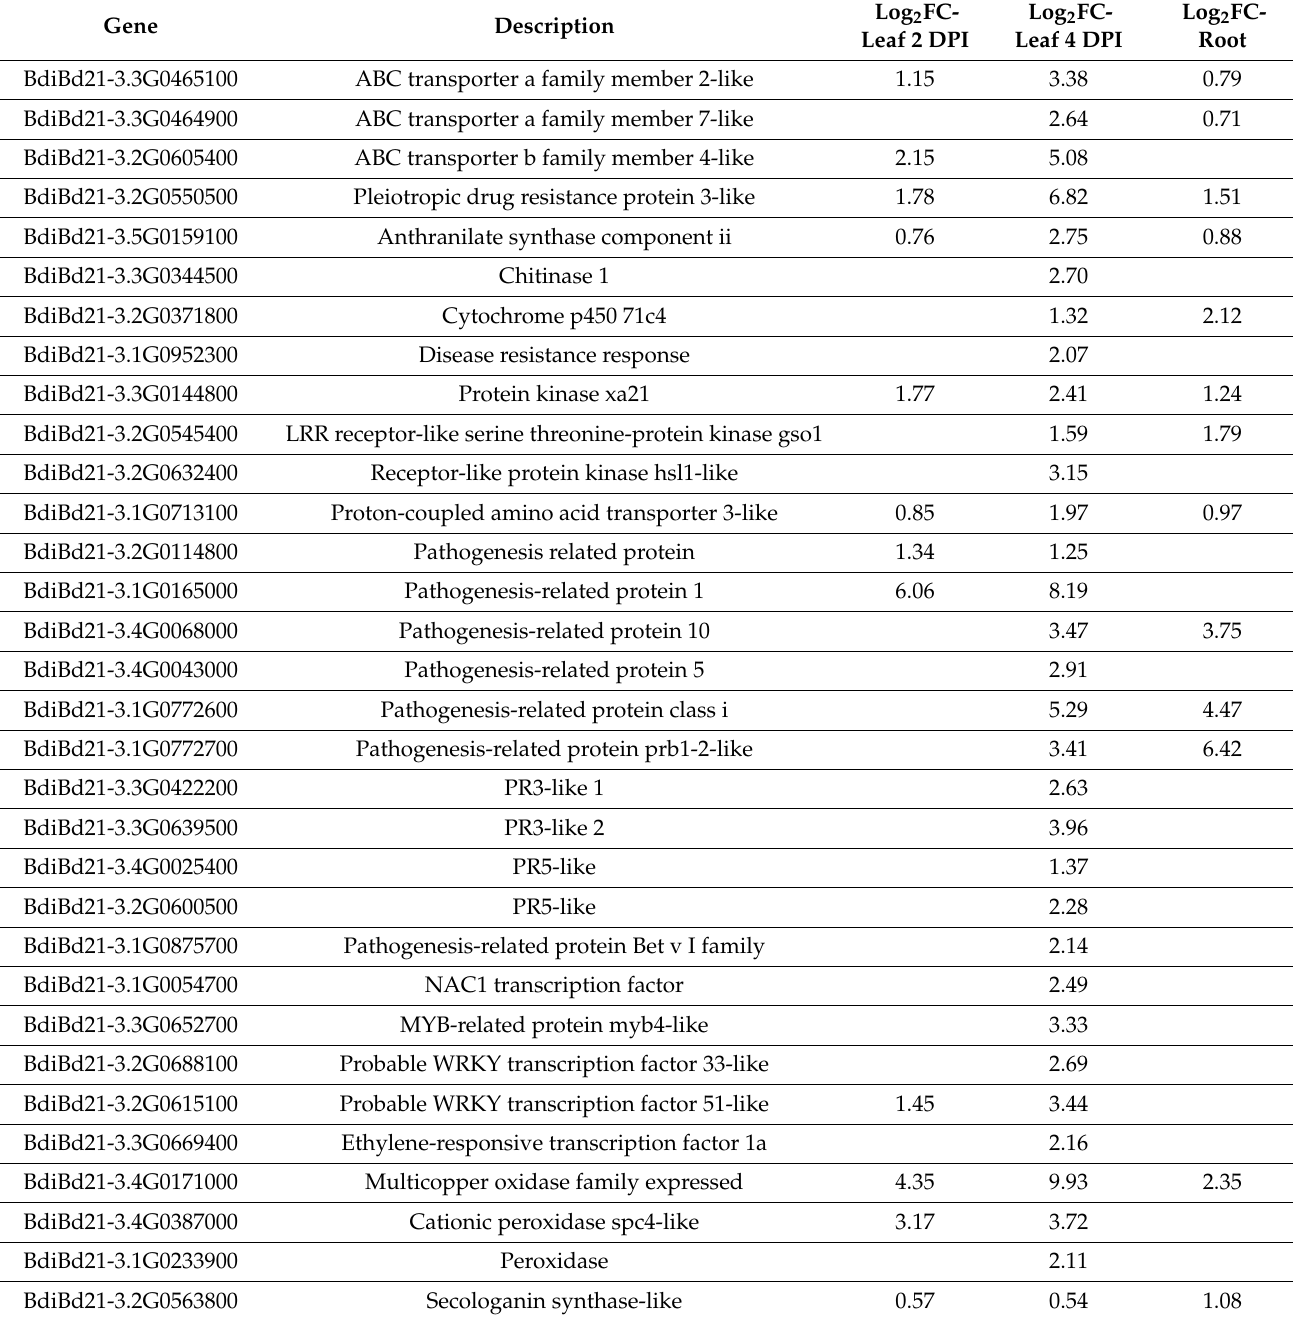
Table 2. Selected defense-related Bd DEGs (padj < 0.05) during infection of leaves and roots by M. oryzae .